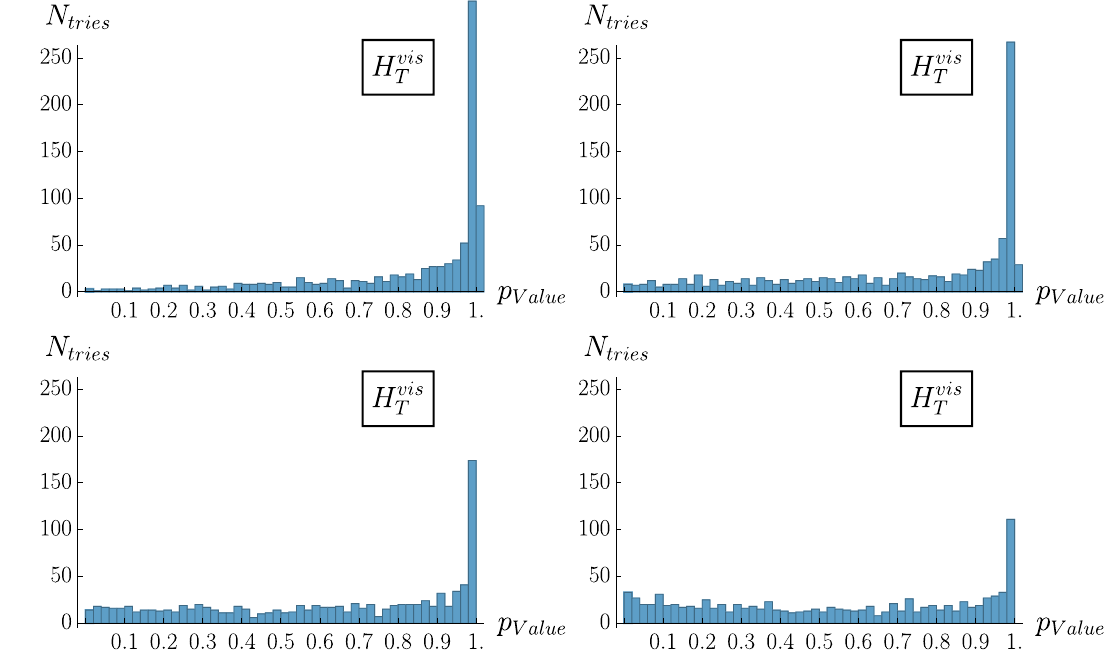
Fig. 11 Thedistributionof p -valuesfortheKolmogorov–Smirnovtest statistic for the NLO QCD differential cross section for pp → t ¯ tW + and pp → t ¯ tW − in the multi-lepton final state as a function of H v is √ s = 13 TeV. A different number of bins is assumed for the LHC with